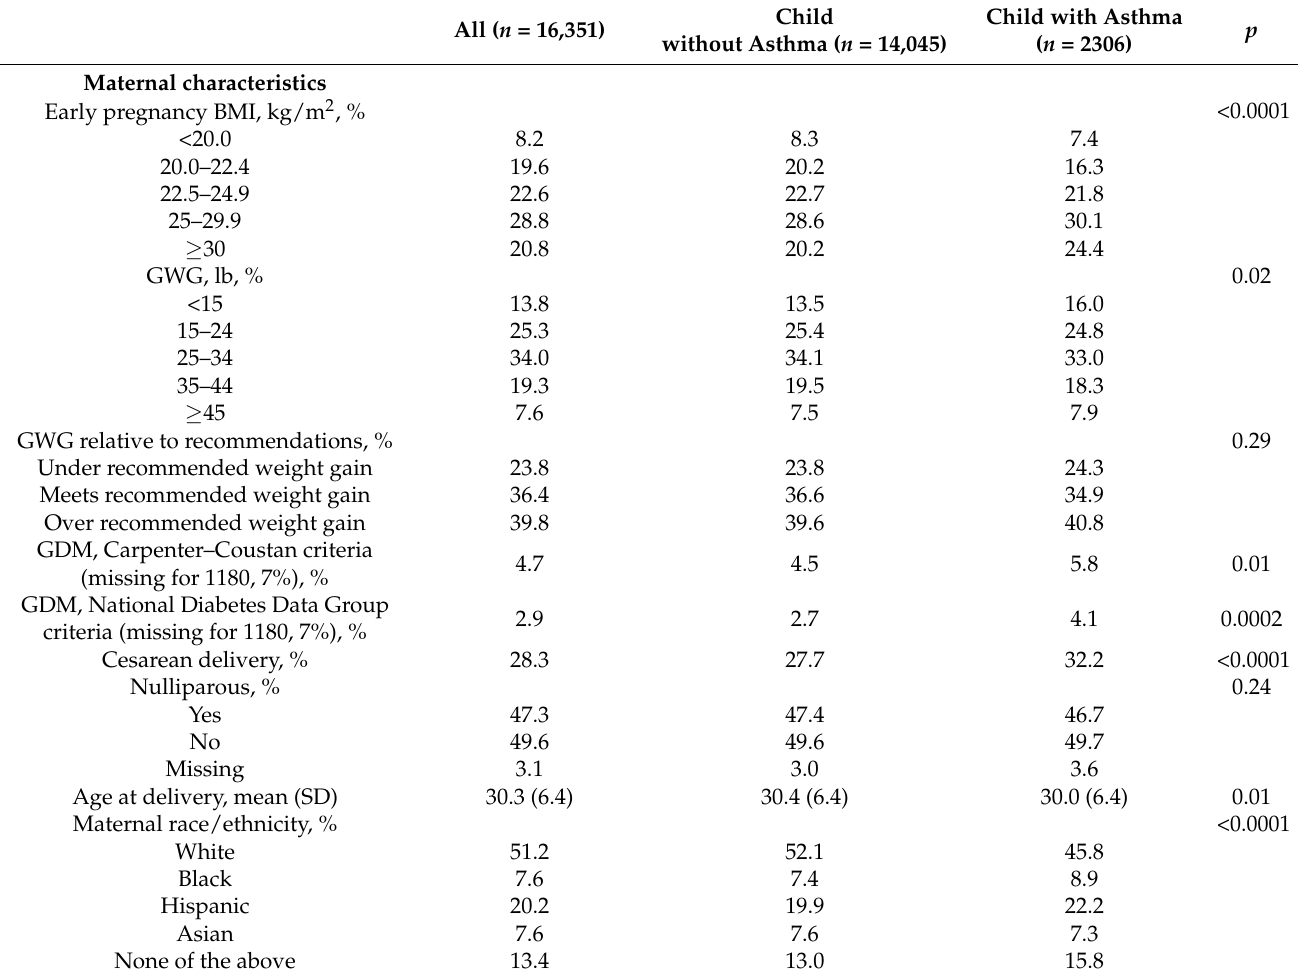
Table 1. Maternal and child’s characteristics according to the child’s asthma